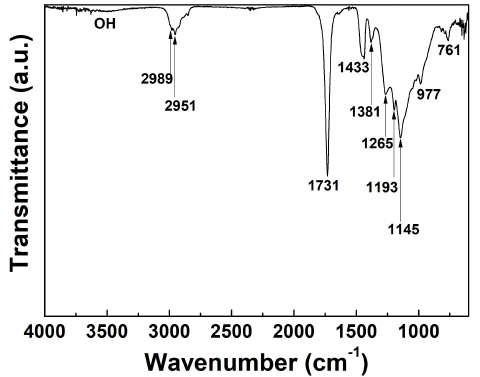
Figure 1. Fourier transform infrared spectroscopy (FT-IR) spectra of plasma-polymerized methyl methacrylate (pPMMA) thin films grown on a glass substrate when using the proposed atmospheric pressure plasma (APP) polymerization technique after 90 min deposition.